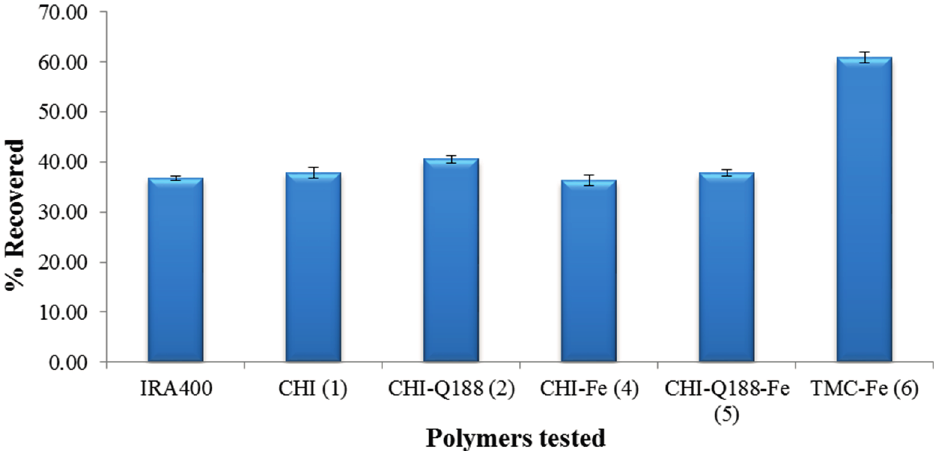
Figure 5. The % ClO (cid:2872)(cid:2879) retention capabilities of the polymers tested [chitosan (1), CHI-Q188 (2), chitosan-Fe (4), CHI-Q188-Fe (5) and TMC-Fe (6)] versus the commercially available IRA 400